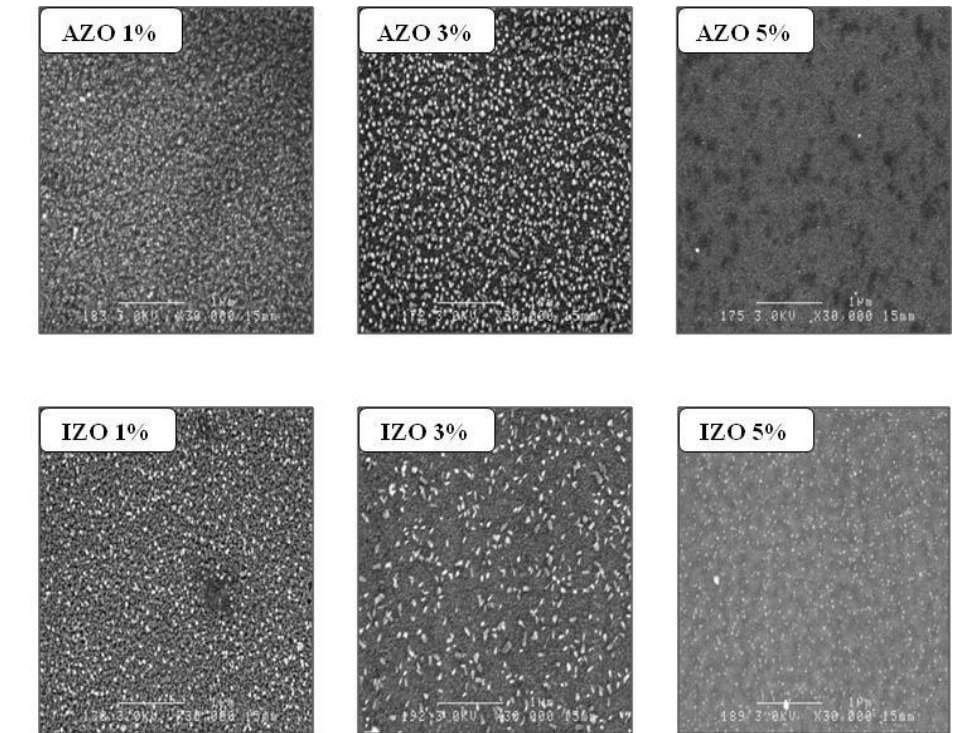
Figure 3. SEM micrographs of undoped ZnO, AZO, and IZO thin films deposited at various doping concentrations.